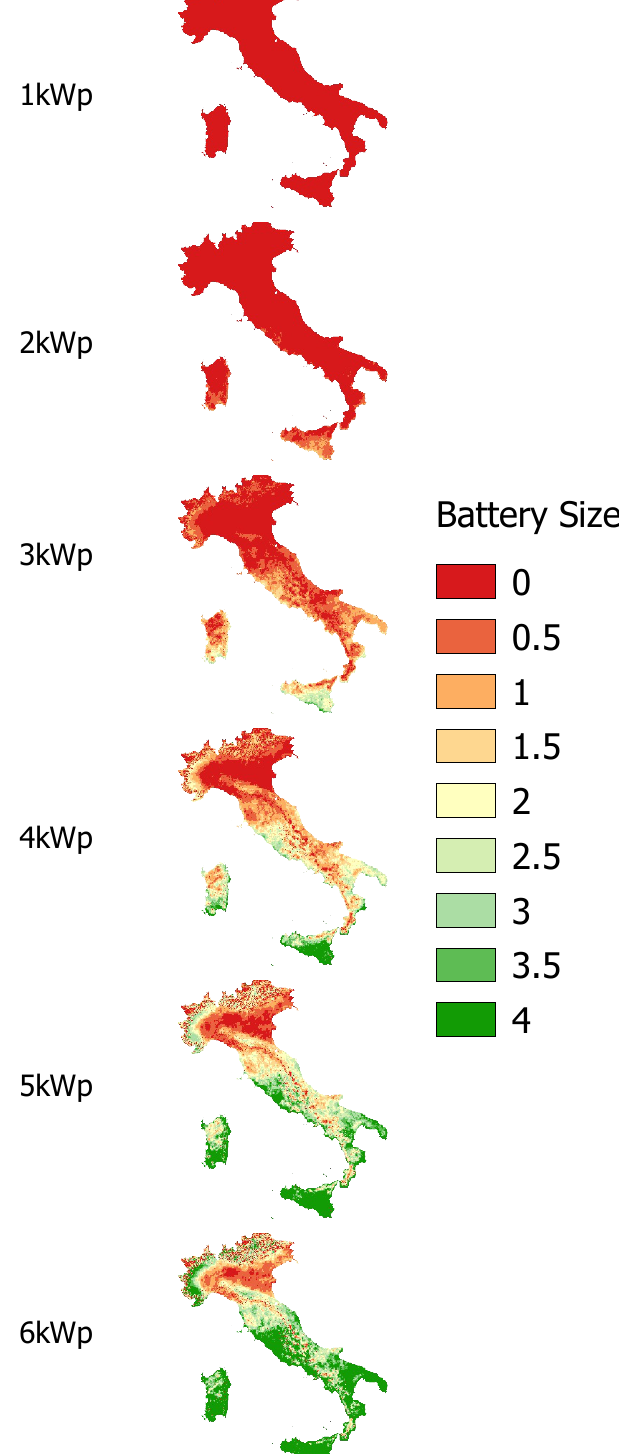
Figure A9. Battery size for E L = 4000